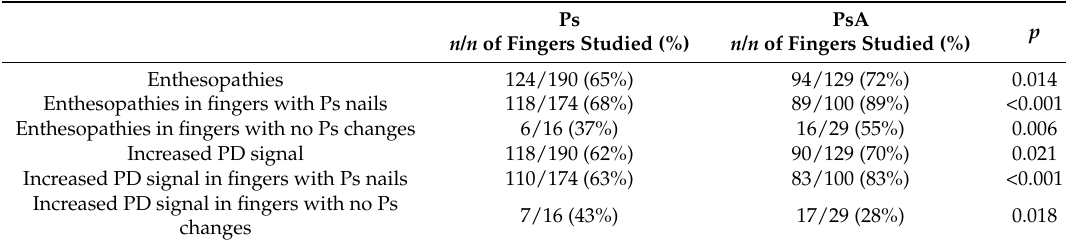
Table 3. Total number of ultrasound